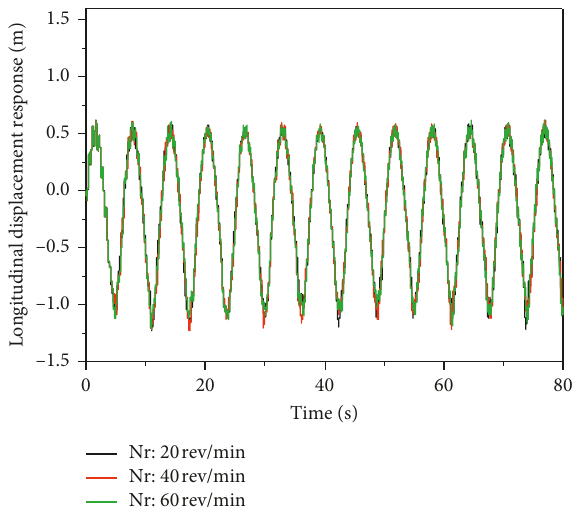
Figure 20: Effect of bit speed on longitudinal displacement response.